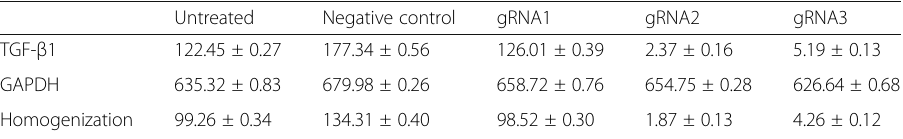
Table 2 Densitometric analysis of TGF- β 1 protein expression levels